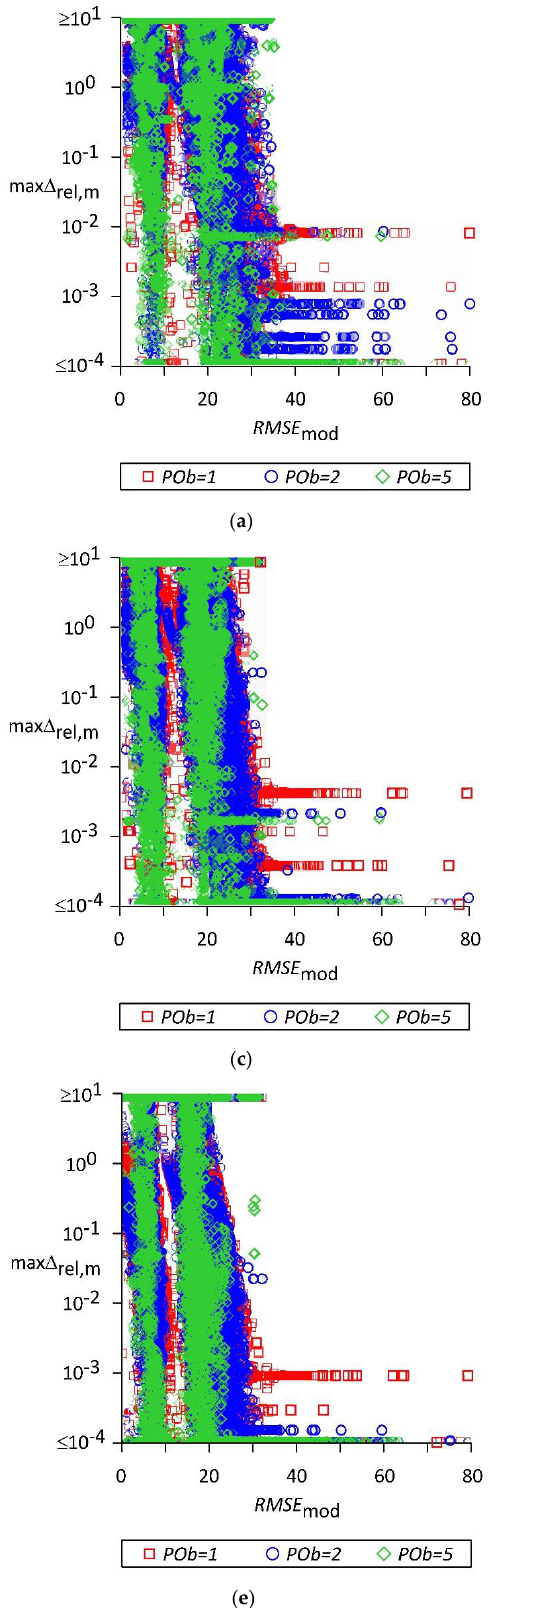
Figure 11. The maximum relative error of the probabilistic moments max Δ rel,m for different degrees of the base reference POb as a function of the RMSE mod criterion: ( a ) α max *( x ) = 0.30, ( b ) α max *( x ) = 0.25, ( c ) α max *( x ) = 0.20, ( d ) α max *( x ) = 0.15,